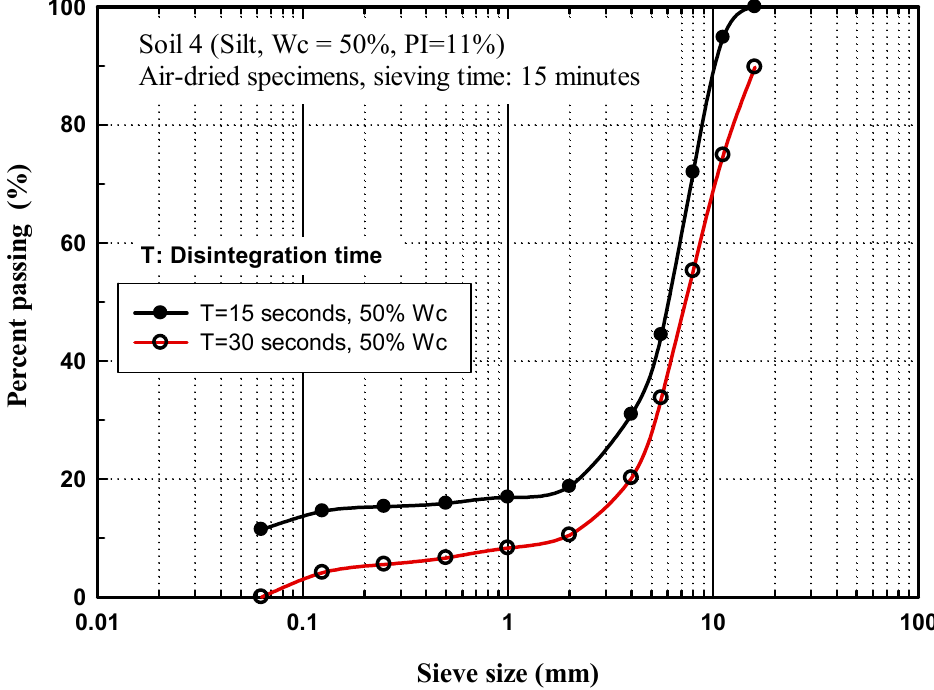
Figure 13. Pass percentage versus sieve size for air-dried specimens of Soil 4 prepared at different disintegration times.